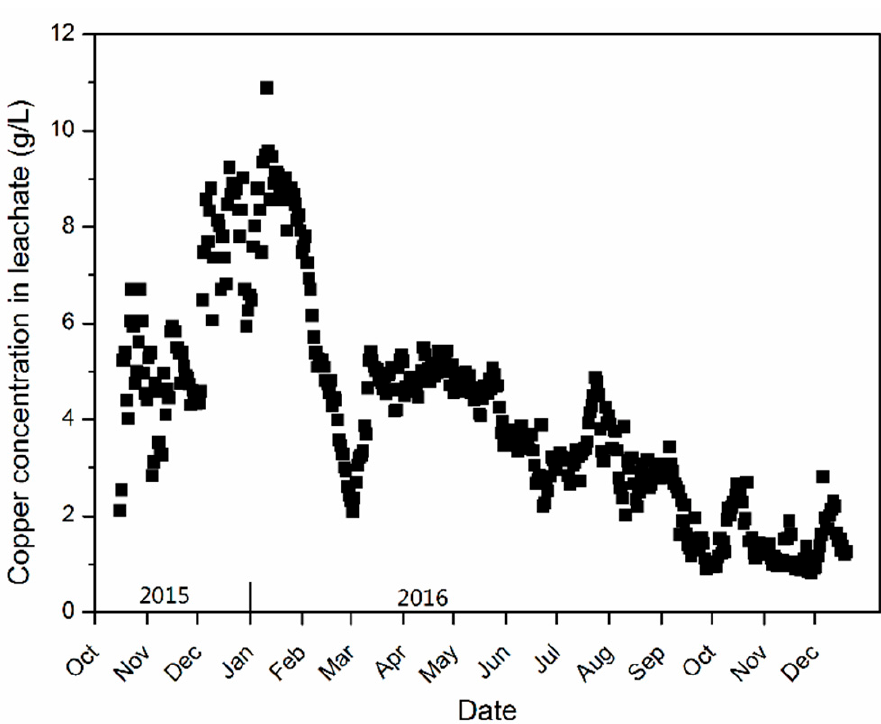
Figure 9. Copper concentration in the leachate during the heap leaching. Before December 2015, open cycle irrigation with river water; then the leachate solution was cycling used as irrigation solution not only in this cell, and also was pumped to other new cells; and then after March 2016, the solvent extraction and electro-winning started, the raffinate was also used as the irrigation solution.